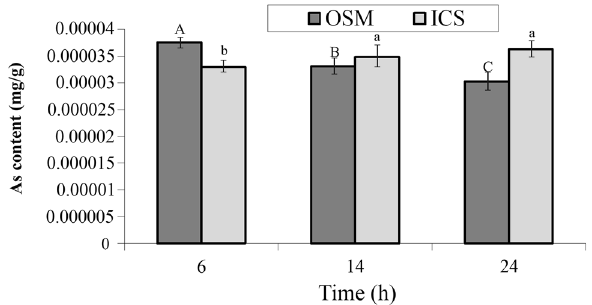
Fig. 4 Temporal response of As bioaccumulation properties of HS12 strains onto OSM and in ICS (same scripts (A/a—C/c) over the bars indicate no significant difference)